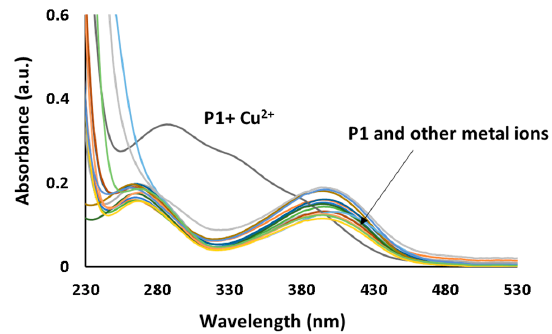
Figure 2. Absorption spectra of P1 (4 × 10 − 3 g/L) in the presence of various metal ions (1.5 × 10 − 4 M aliquots) in acetonitrile.